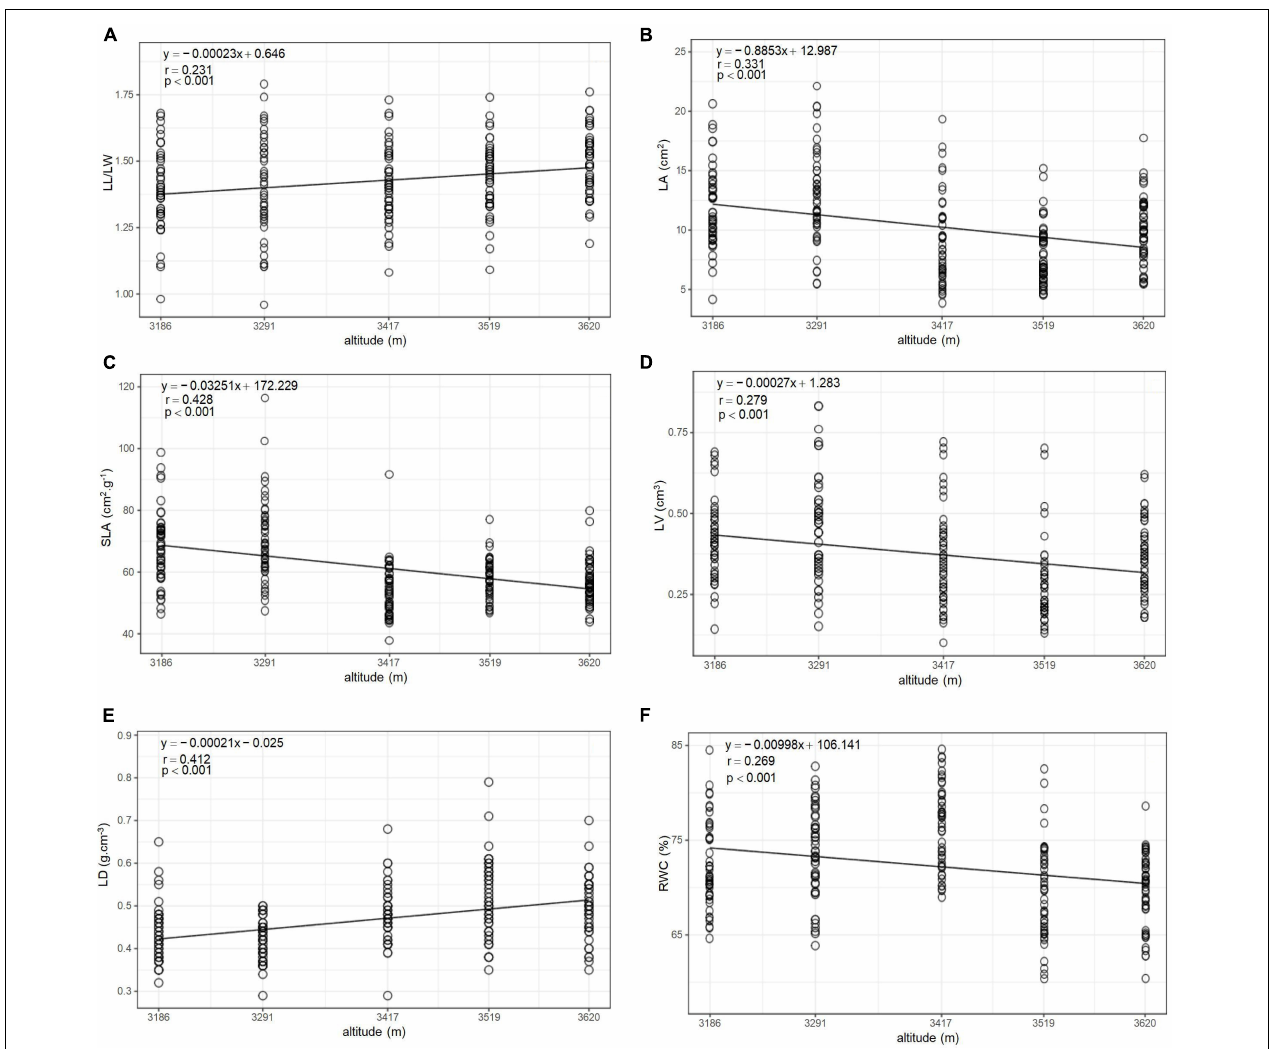
FIGURE 1 | Altitudinal distribution of leaf functional traits of Quercus aquifolioides in Southeastern Tibet. (A) Altitudinal distribution of leaf length-width ratio (LL/LW); (B) altitudinal distribution of leaf area (LA); (C) altitudinal distribution of specific leaf area (SLA); (D) altitudinal distribution of leaf volume (LV); (E) altitudinal distribution of leaf density (LD); and (F) altitudinal distribution of relative water content (RWC).